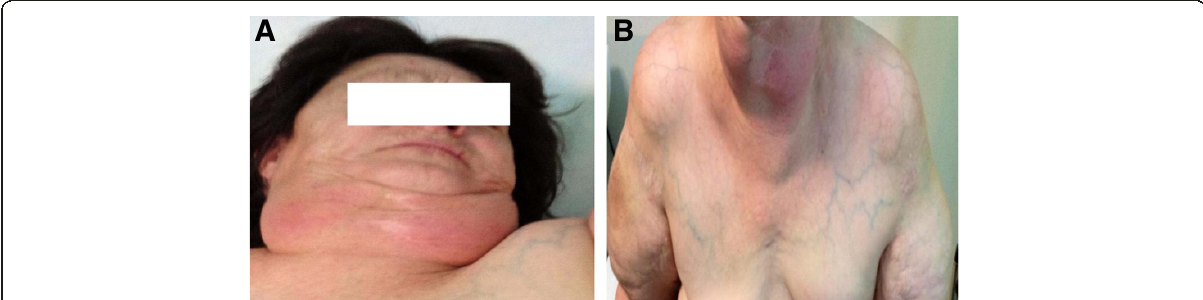
Figure 1 Picture of the patient showing Type I MSL with symmetric accumulation of lipomatous tissue in the anterior cervical region (A) and upper arms